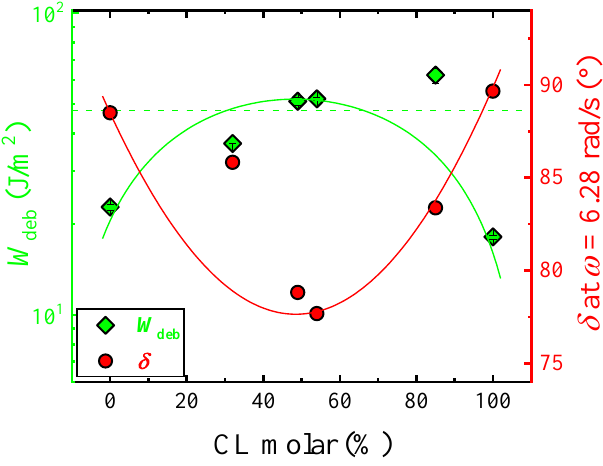
Figure 11. Energy of adhesion W deb , obtained at a debonding velocity of 0.314 mm/s ( ω = 6.28 s − 1 ) and phase angle δ obtained at ω = 6.28 rad/s, as a function of composition. The horizontal segmented line corresponds to the value of W deb for the hot melt Valco. The solid lines are guides to the eye.